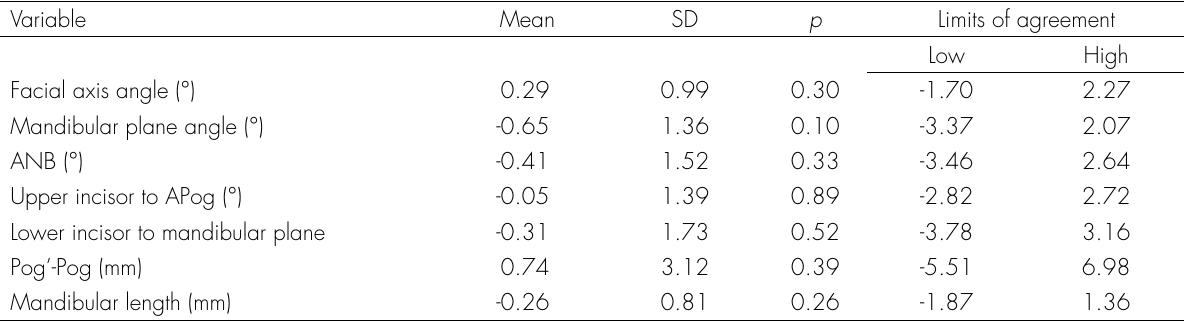
Table II. Error of landmark location and cephalometric measurement.